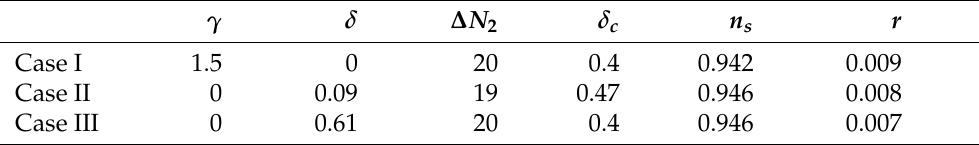
Table 5. The parameters corresponding to the PBH density fraction in Figure 9. The n s and r are computed with the total ∆ N = 54 e-folds before the end of